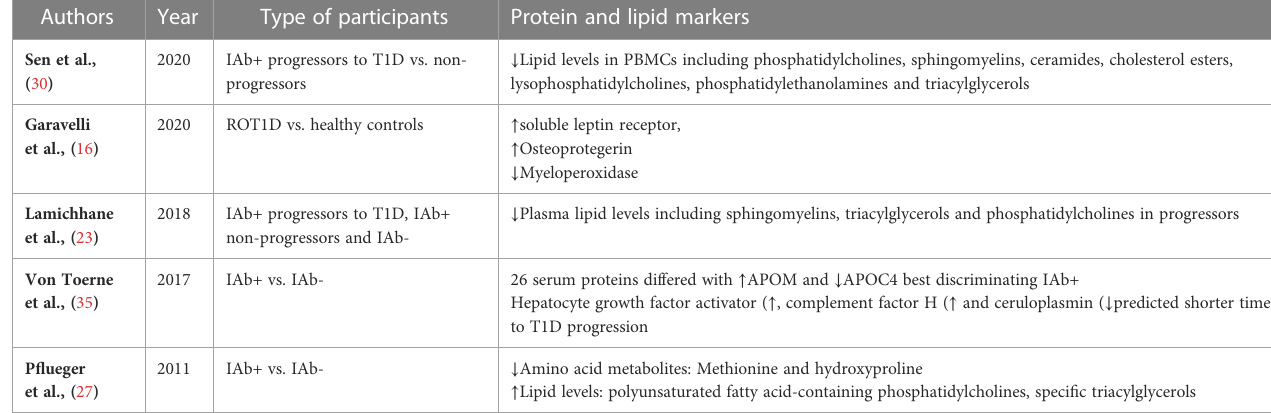
TABLE 3 Protein and lipid markers associated with progression to